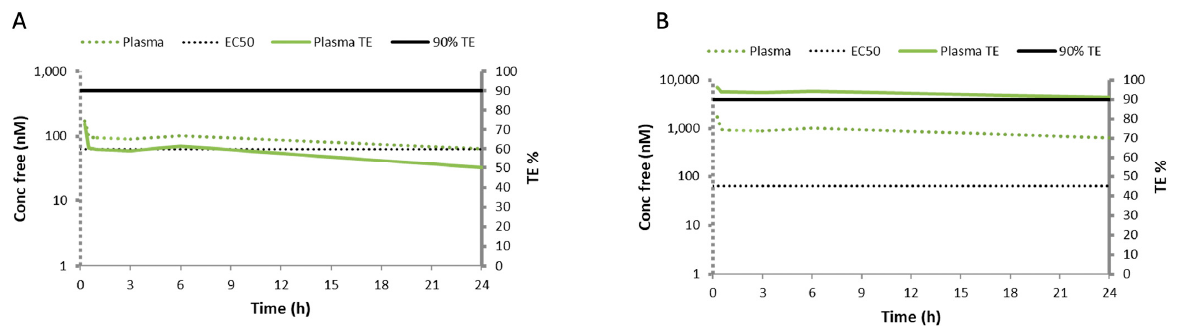
Figure 4. Target engagement percentage (TE%) evaluation based on the pharmacokinetic curve obtained after administering 1 mg/kg of intraperitoneal rosiglitazone and considering the unbound plasma and the EC50 values determined for rosiglitazone in vitro. ( A ) The concentration of free rosiglitazone (Conc free, solid green line), which estimated a target engagement of 50%, far from the optimal 90% TE (solid black line). ( B ) The linear scaling model to an intraperitoneal rosiglitazone dose of 10 mg/kg estimated a robust TE% > 90%, denoted by superimposed plasma and TE% curves. Nevertheless, the daily administration of 10 mg/kg of RGZ had deleterious effects on lung function, showing a significantly lower inspiratory capacity and lung compliance (C st